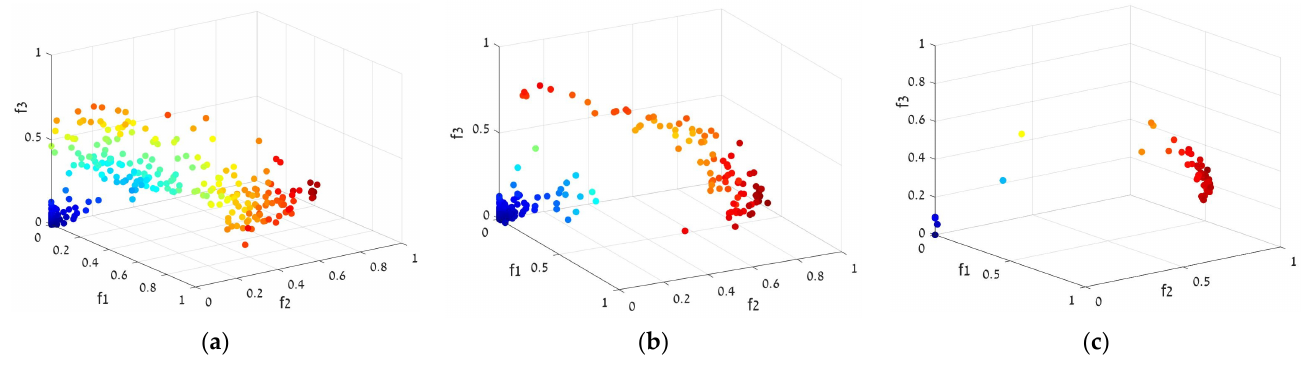
Figure 3. Pareto front dynamics in multi-objective optimization of the genetic algorithm. ( a – c ) refer to 5, 15, and 50 generations of the GA, respectively.